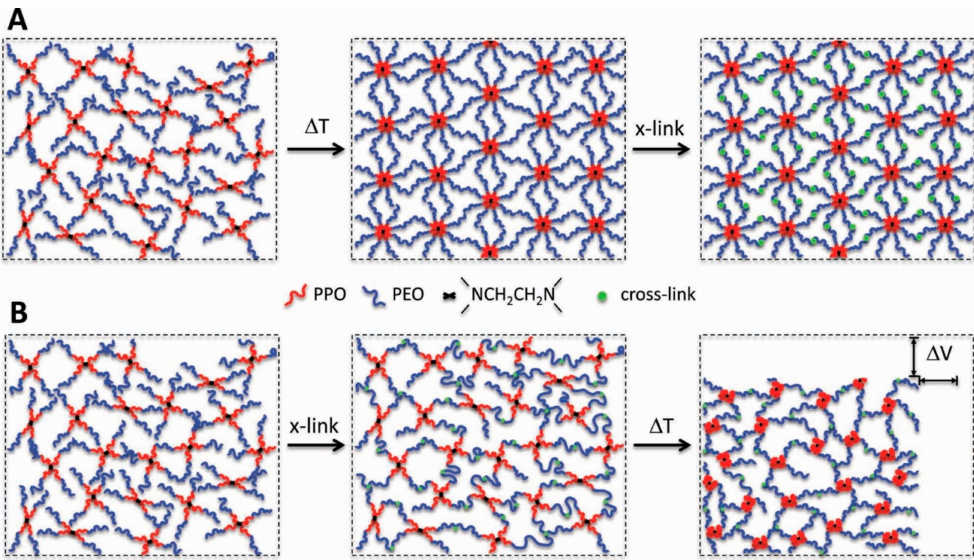
Figure 9. Schematic illustration of chemically cross-linked poly(propylene oxide)-poly(ethylene oxide) (PPO-PEO) block copolymer thermoresponsive gels (not to scale), demonstrating the significance of controlling the sequence of thermal transition and chemical cross-linking. ( A ) In the “tandem” method of Cellesi et al. [82,83], chemical cross-linking occurs after thermal equilibration. ( B ) In the present method, chemical cross-linking of cT is intended to occur prior to thermal equilibration, producing a PPO-PEO block copolymer network. Subsequent warming induces thermal transition of the PPO segments from hydrophilic to hydrophobic, producing volumetric shrinkage and toughening the network. Reproduced with permission from Ref. [81], Copyright 2013, Wiley-VCH Verlag Gmbh & Co. KGaA. Poly(N-isopropylacrylamide) (PNIPAM) hydrogels are widely studied thermosensitive hydrogels ◦ with potential medical applications due to their LCST (32 C) being close to human body